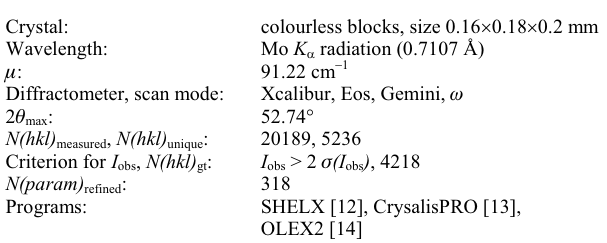
Table 1. Data collection and handling.